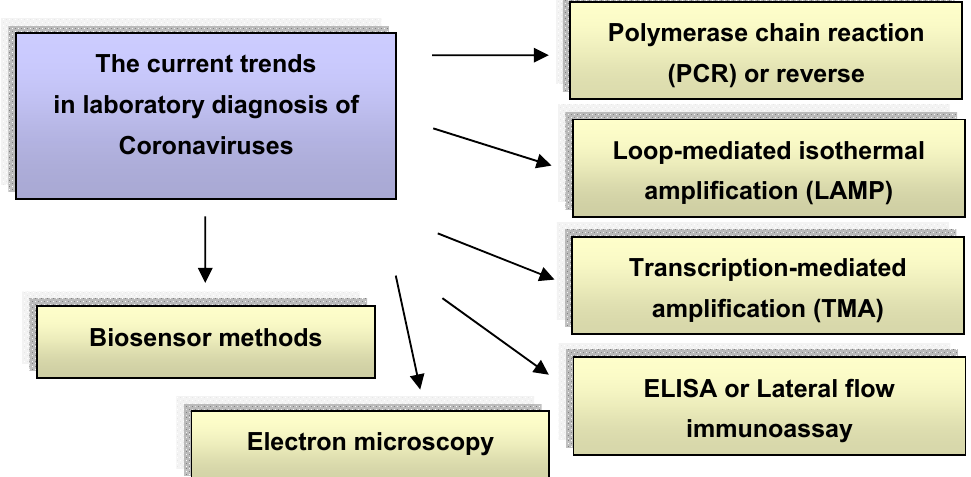
Figure 1. Modern trends in laboratory diagnosis of coronaviruses.